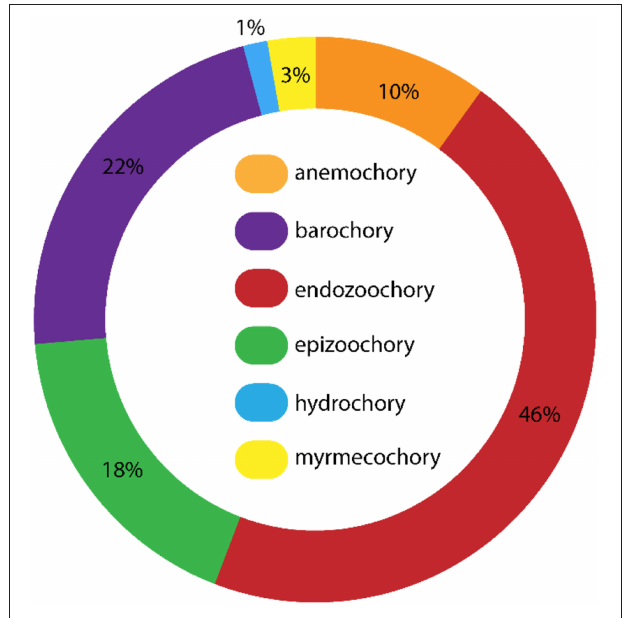
FIGURE 2 | Relative frequencies of different dispersal syndromes (Baseflor, Julve, 1998) assigned to all the plant taxa dispersed by corvids through endozoochory, according to Heintze’s complete list ( n = 148 taxa, another nine species were missing because their dispersal syndrome was unknown, see Table S1 ). Anemochory is wind dispersal, barochory is self-dispersal, hydrochory is water dispersal, epizoochory is dispersal stuck on the outside of animals, myrmecochory is dispersal by ants (see Julve, 1998; Perez-Harguindeguy et al.,